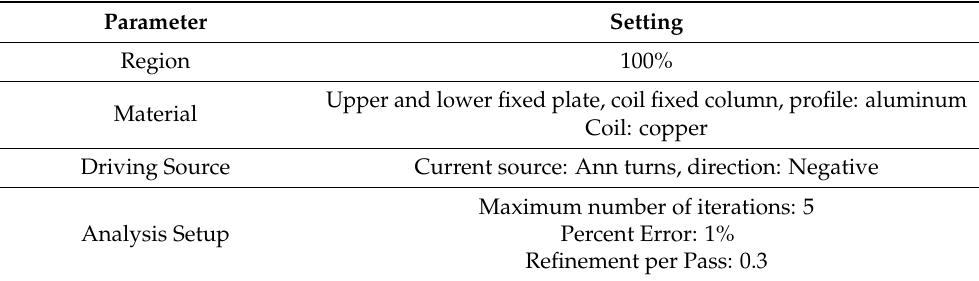
Table 2. Simulation Parameters of the static magnetic field.